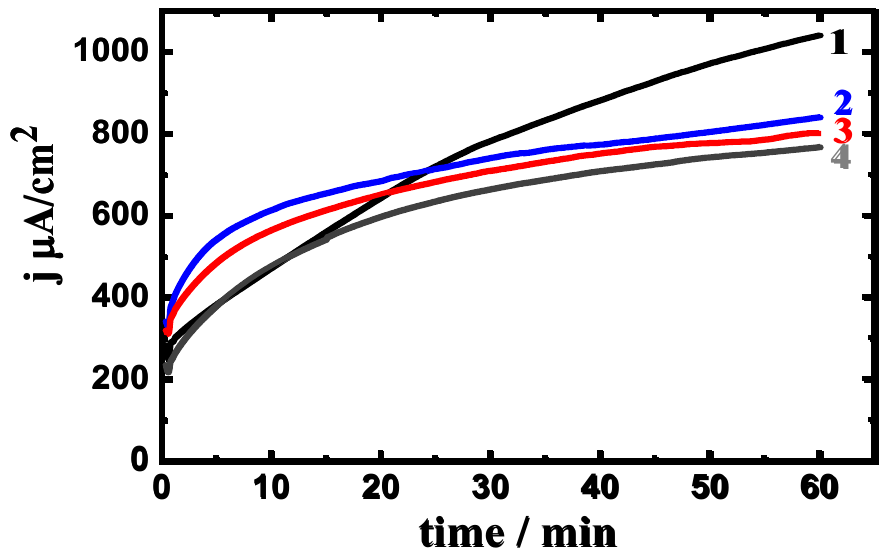
Figure 9. Current curves collected at − 475 mV (Ag/AgCl) for iron in 3.5% NaCl solutions containing (1) 0.0, (2) 5 × 10 −5 , (3) 1 × 10 −4 , and (4) 5 × 10 −4 M HAO after 48 h immersion.